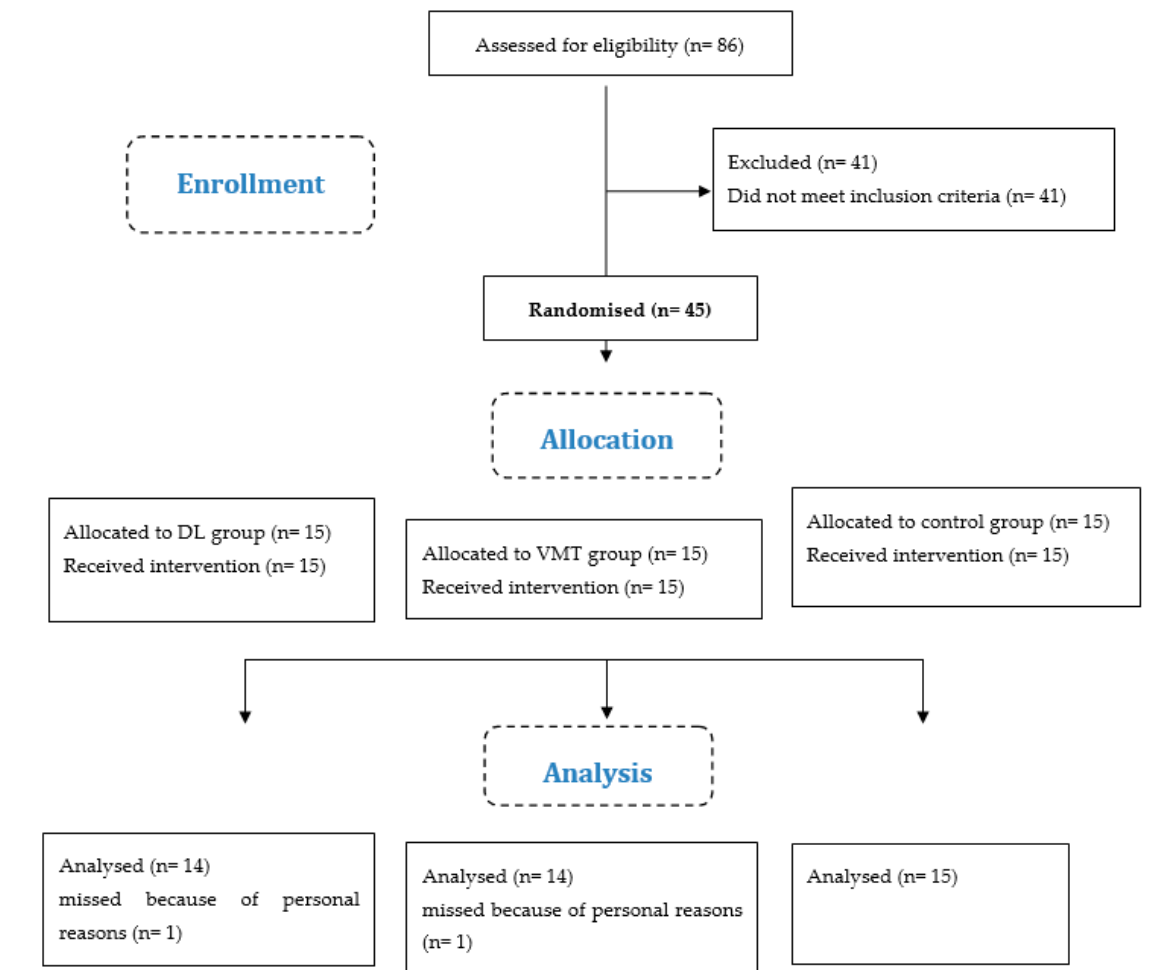
Figure 1. Flow diagram of the study. Abbreviations: DL: differential learning; VMT: visuo-motor training; n: number of athletes (see also Supplementary Material).